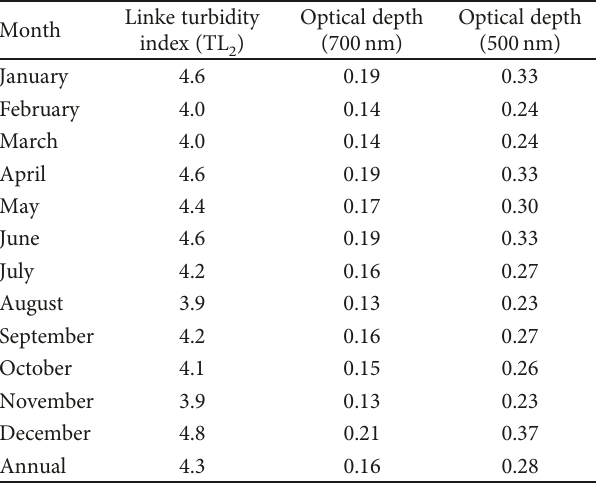
Table 2: Linke turbidity index and the aerosol optical depth for 700 and